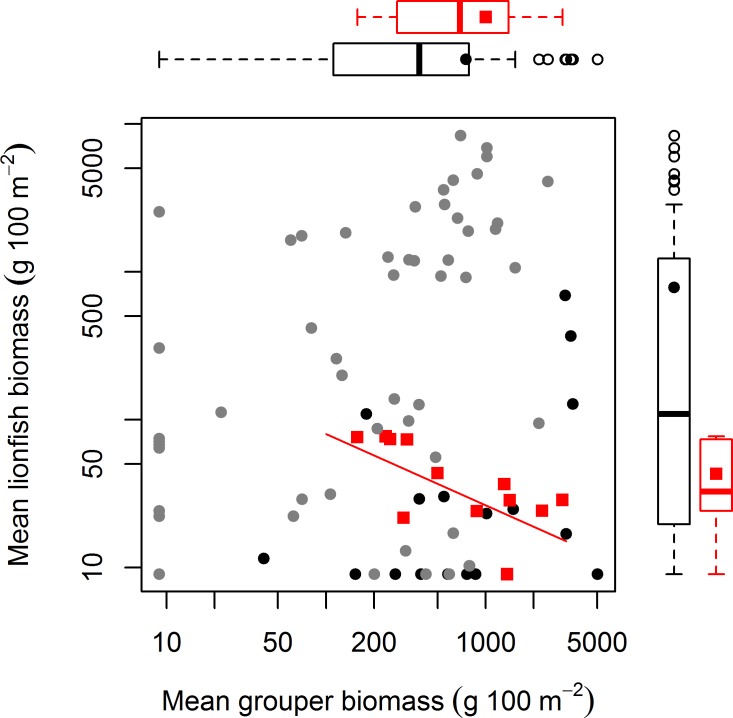
Relationship between mean grouper and lionfish biomass.In this study, 71 fore reefs (black dots protected sites, grey dots non-protected sites) were surveyed and analyzed across the Caribbean. For comparison, we included 12 sites (red squares) surveyed at Exuma Cays Land and Sea Park by Mumby, Harborne & Brumbaugh (2011). The red fitted line is for the linear regression model by Mumby, Harborne & Brumbaugh (2011) that explain 56% of the variability of lionfish biomass due to grouper abundance. Note that red squares represent ∼16% of all sites. Boxplots are median (vertical or horizontal line), 50 and 90 percentiles for lionfish biomass (right) and grouper biomass (top). Boxplots with black dots (general mean) correspond to our study and boxplots with red squares (general mean) to Mumby, Harborne & Brumbaugh (2011). The empty circles are outliers. Axes are in log scale.